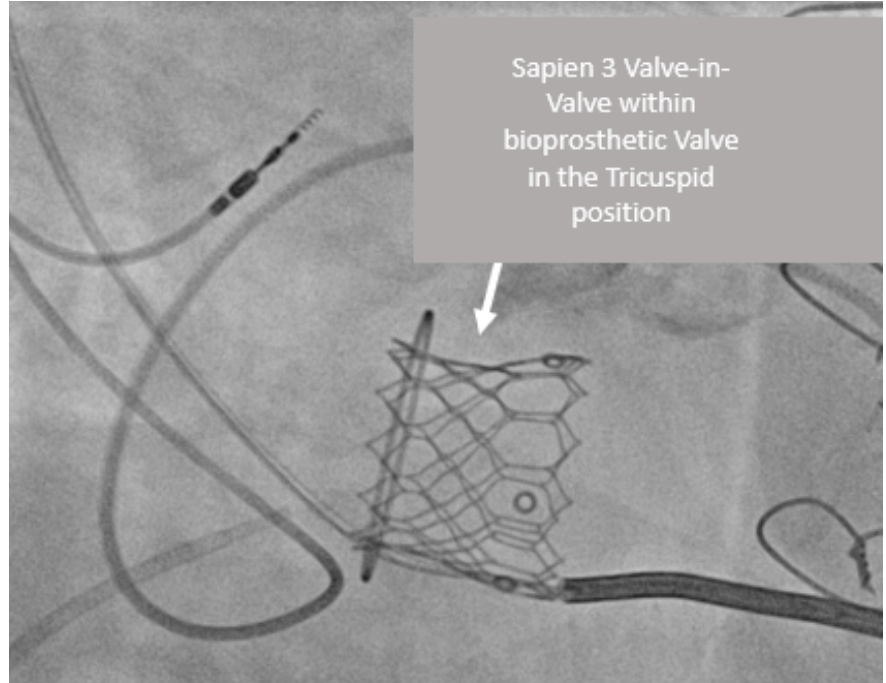
Figure 3. Sapien 3 valve-in-valve within bioprosthetic valve in the tricuspid position with cardiac resynchronization therapy defibrillator device in-situ in the RAO 50 Caudal 10 view. resynchronization therapy defibrillator device in-situ in the RAO 50 Caudal 10